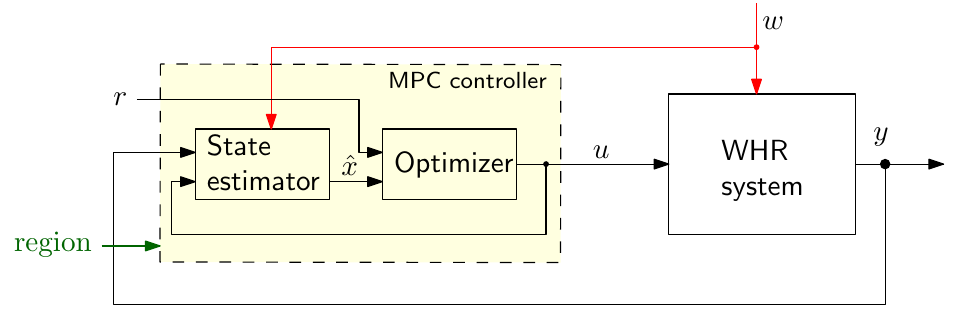
Figure 5. Schematic representation of the control